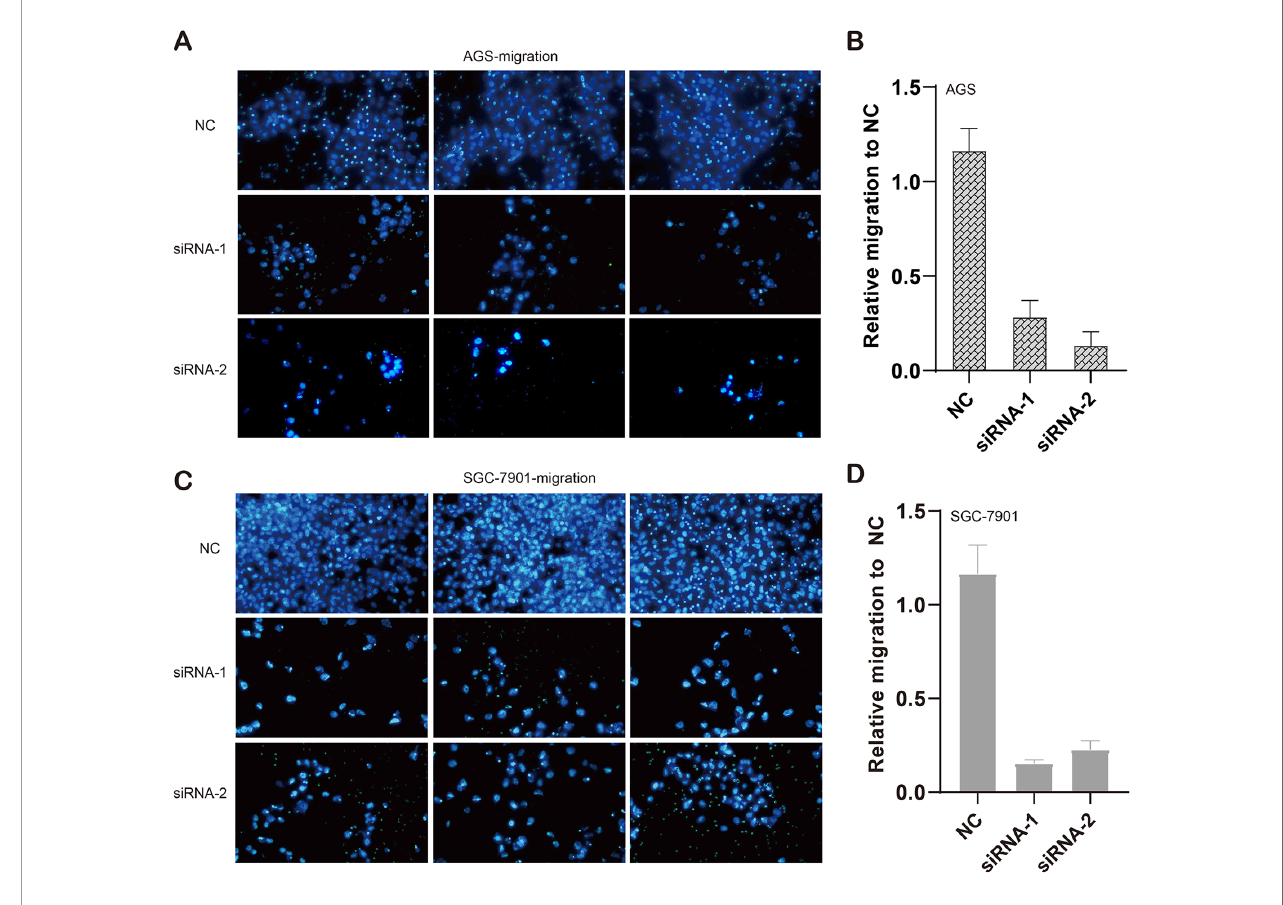
FIGURE 6 | Knockdown of ILF3-AS1 induced cell migration in GC. (A, B) Knockdown of ILF3-AS1 induced cell migration in AGS cells. (C, D) Knockdown of ILF3- AS1 induced cell migration in SGC-7901